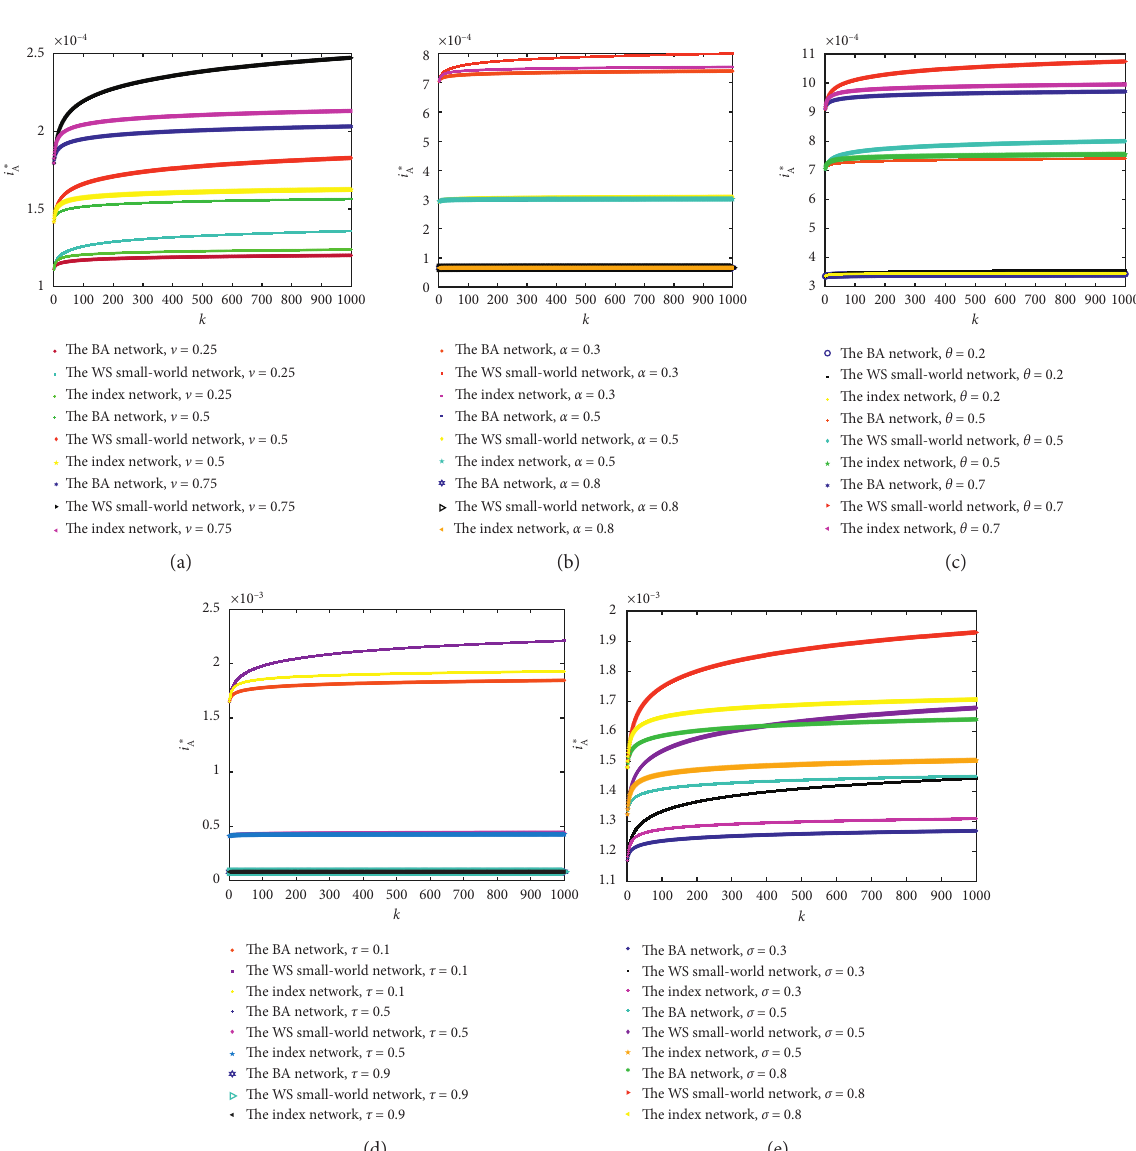
Figure 5: Evolutionary characteristics of the impact of the degree of business counterparties. (a) The impact of the enterprise counterparty degree k on i ∗ A under different network structures and business counterparty initial economic shocks ] . (b) The impact of the enterprise counterparty degree k on i ∗ A under different network structures and different enterprise counterparty risk perception levels α . (c) The impact of the enterprise counterparty degree k on i ∗ A under different network structures and influence θ i of the enterprise counterparty. (d) The impact of the corporate counterparty’s degree k on i ∗ A under different network structures and different the risk spillover abilities of corporate counterparties τ . (e) The impact of the enterprise counterparty degree k on i ∗ A under different network structures and different corporate counterparties’ leverage levels σ